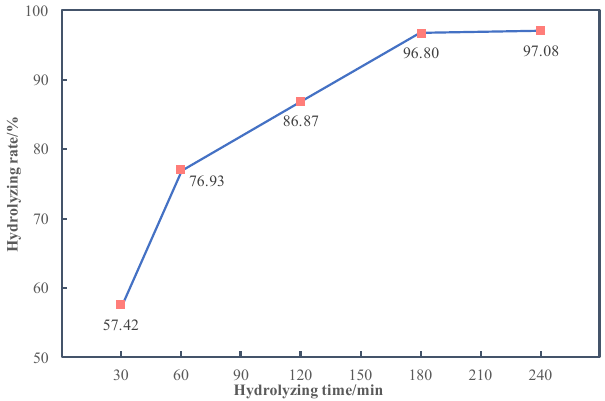
Figure 10. Effect of temperature on hydrolyzing rate of titanium.